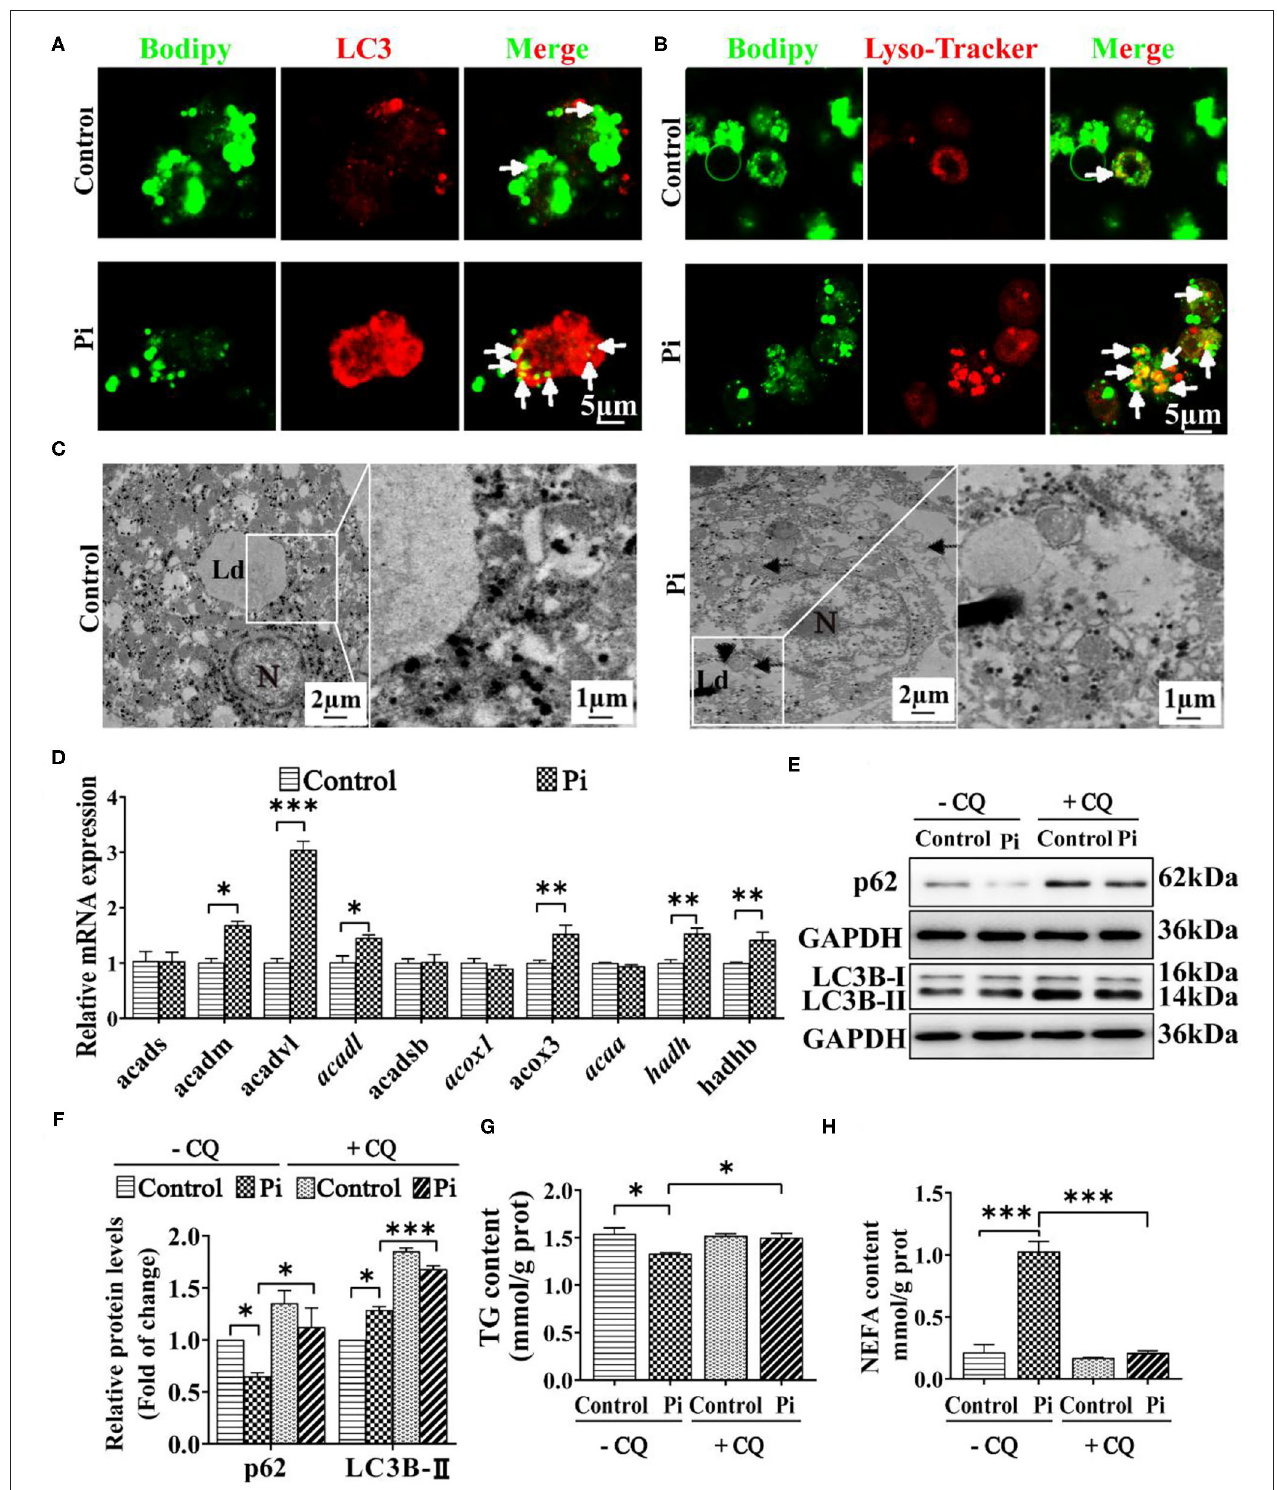
FIGURE 6 | Phosphorus incubation promoted lipophagy in tilapia hepatocytes. (A) Confocal microscopic images of the hepatocytes stained with Bodipy 493/503 and LC3 protein. Arrows indicate the colocalization of LC3 protein with LDs. Scale bar, 5 µ m. (B) Confocal micrograph of hepatocytes stained with Bodipy 493/503 and